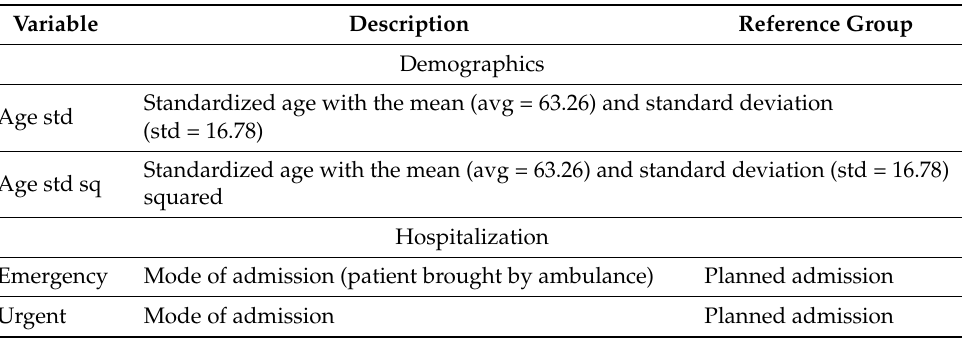
Table 3. Variables that were used only for modeling the risk of death within 90 days of